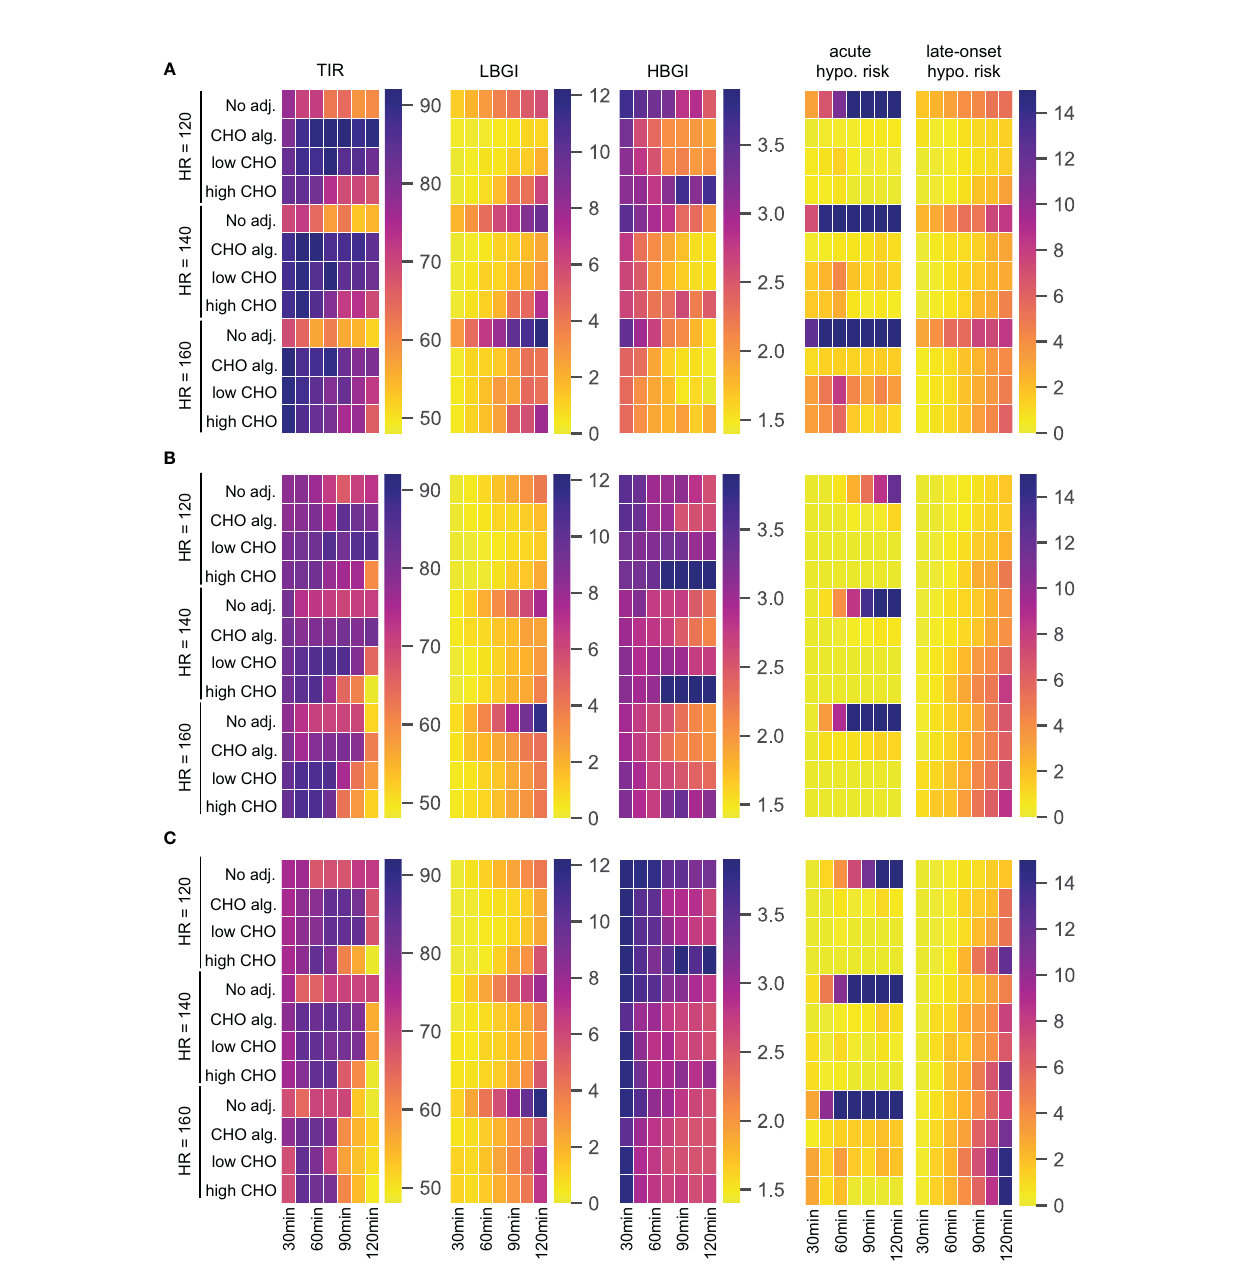
FIGURE 4 | TIR, LBGI and HBGI over 24h-simulations and the corresponding acute and late-onset hypoglycemia risk for different adjustments, intensities, and exercise durations. (A) Scenario 1: exercise in postabsorptive state. (B) Scenario 2: exercise with prior insulin bolus reduction. (C) Scenario 3: exercise without prior insulin bolus